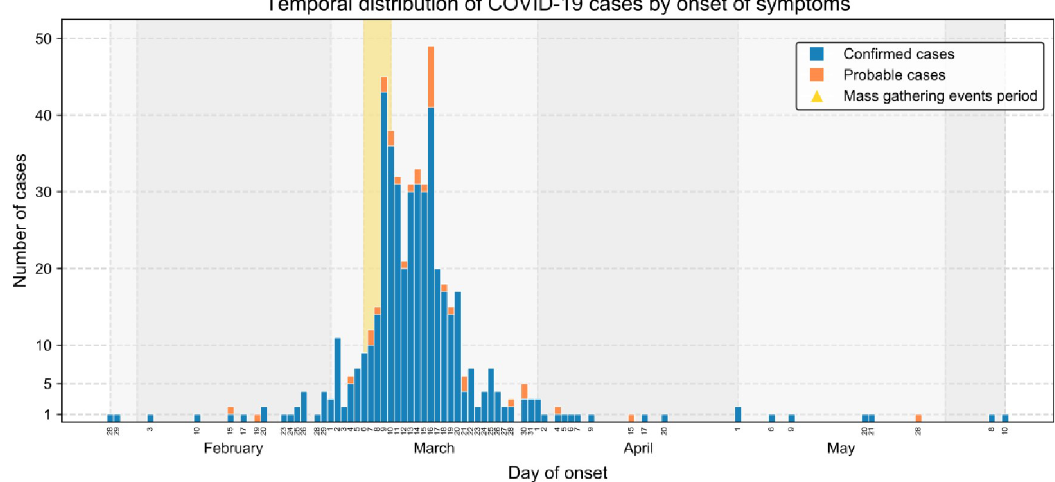
Fig 2. Temporal distribution of COVID-19 cases by onset of symptoms. The numbers of confirmed and probable COVID-19 cases are shown in blue and orange, respectively. The yellow vertical line highlights the time period when the six MGEs took